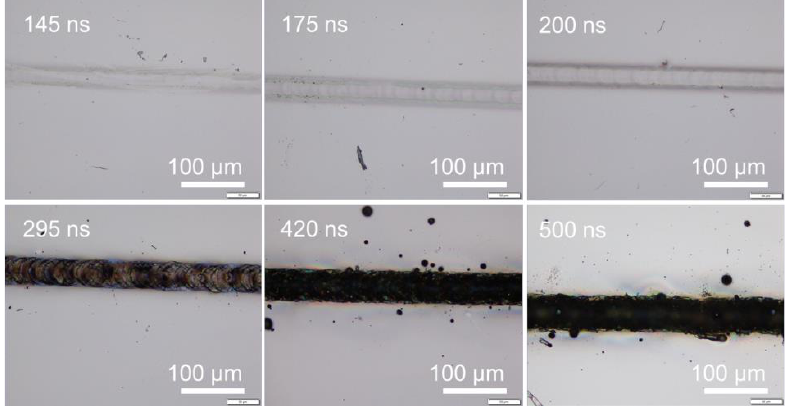
Figure 8. Surface morphologies showing enhanced surface melting with increasing pulse width at 50 mm/s scanning speed.